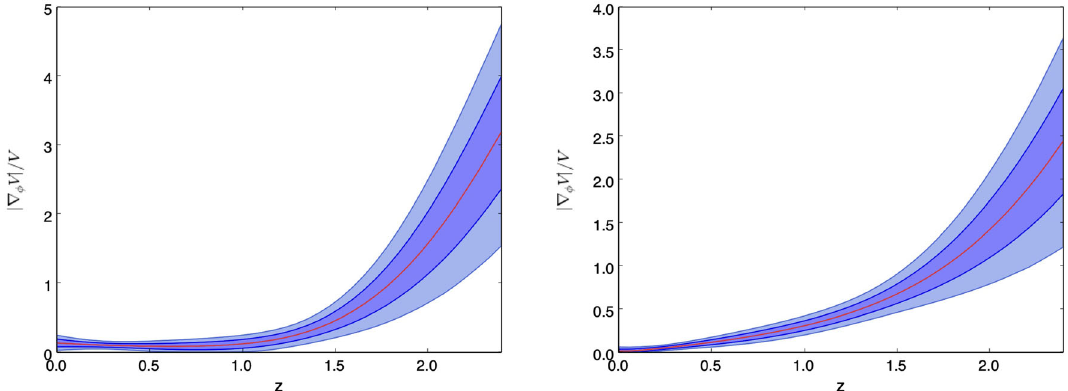
Fig. 5 The GP reconstruction of ω R and (cid:13) R for the 30 H ( z ) samples deducedfromthedifferentialagemethodwith10samplesobtainedfrom the radial BAO method (Table 1) is presented on the upper panel, when H 0 = 73 . 52 ± 1 . 62 km s − 1 Mpc − 1 has been merged to the expansion ratedatausedintheGP.ThebottompanelrepresentstheGPreconstruc- tionofthefunctions ω R and (cid:13) R ,when H 0 = 67 . 40 ± 0 . 5kms − 1 Mpc − 1 has been merged to the expansion rate data used in the GP. The recon- struction thus obtained is for the f ( R ) model given by Eq. (20). The